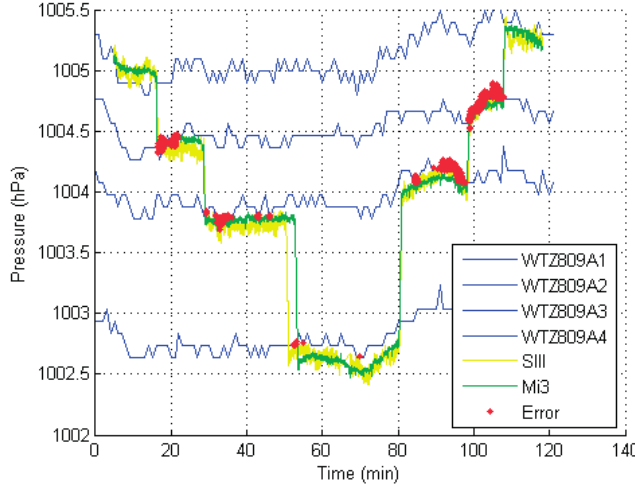
Figure 10. Experimental result in the terminal (using a 1-s time